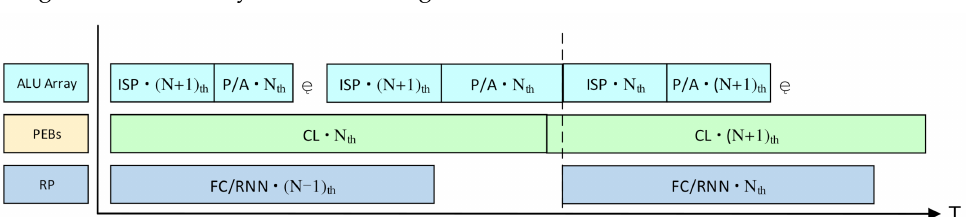
Figure 10. The pipelined workflow for the vision tasks. The P/A means the non-Mac operations such as the pooling and activating. CL is short for the convolutional layers. “N th “ means the operations for the N th